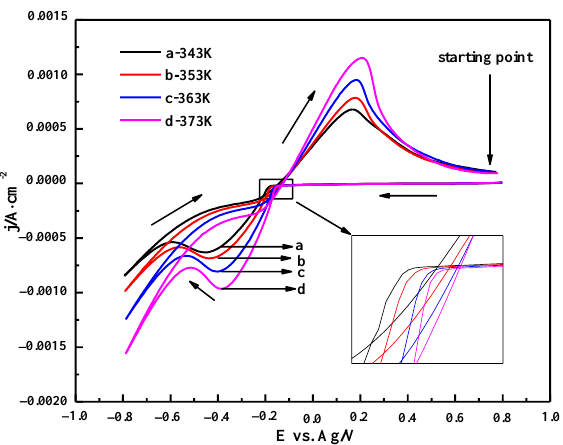
c(BiCl 3 ) = 0.10 M). Figure 11. Cyclic voltammetry curves of ChCl-MA-BiCl 3 at different temperatures (v = 50 mV·s − 1 ,